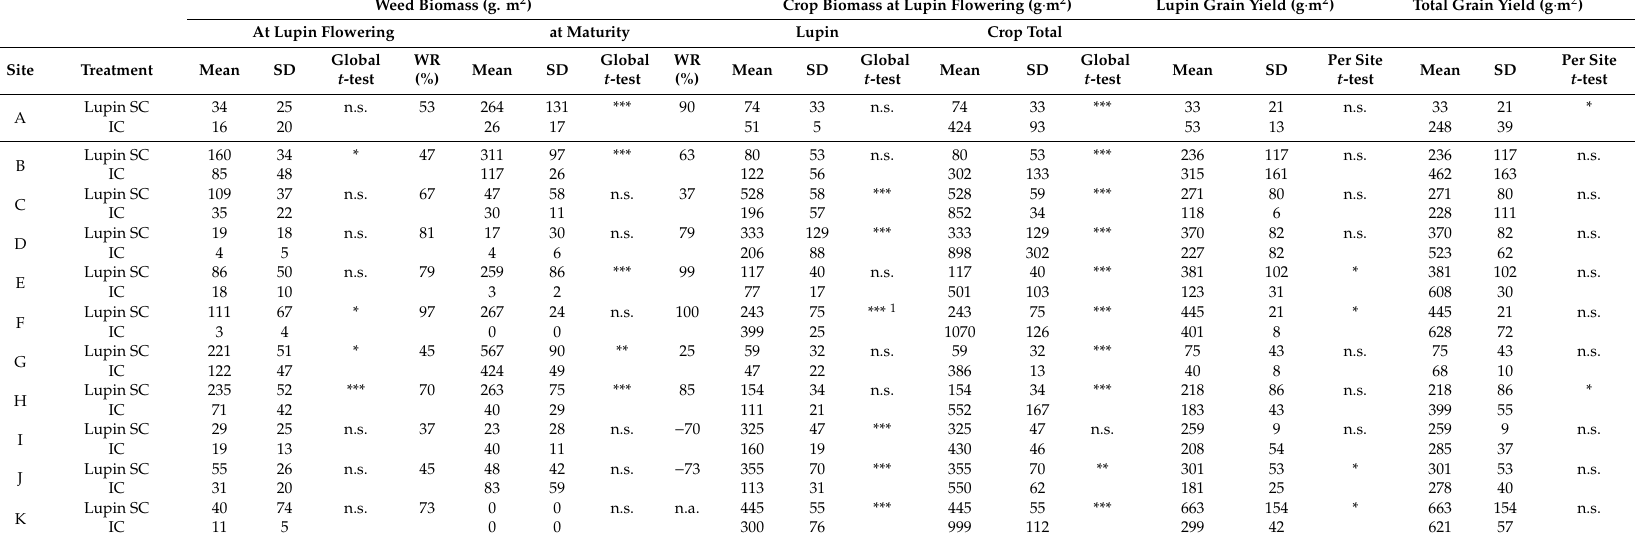
Table 2. Weed biomass (dry matter), crop biomass (dry matter), lupin grain dry yield and total grain dry yield in lupin sole crop (SC) and lupin-triticale intercrop (IC) on the 11